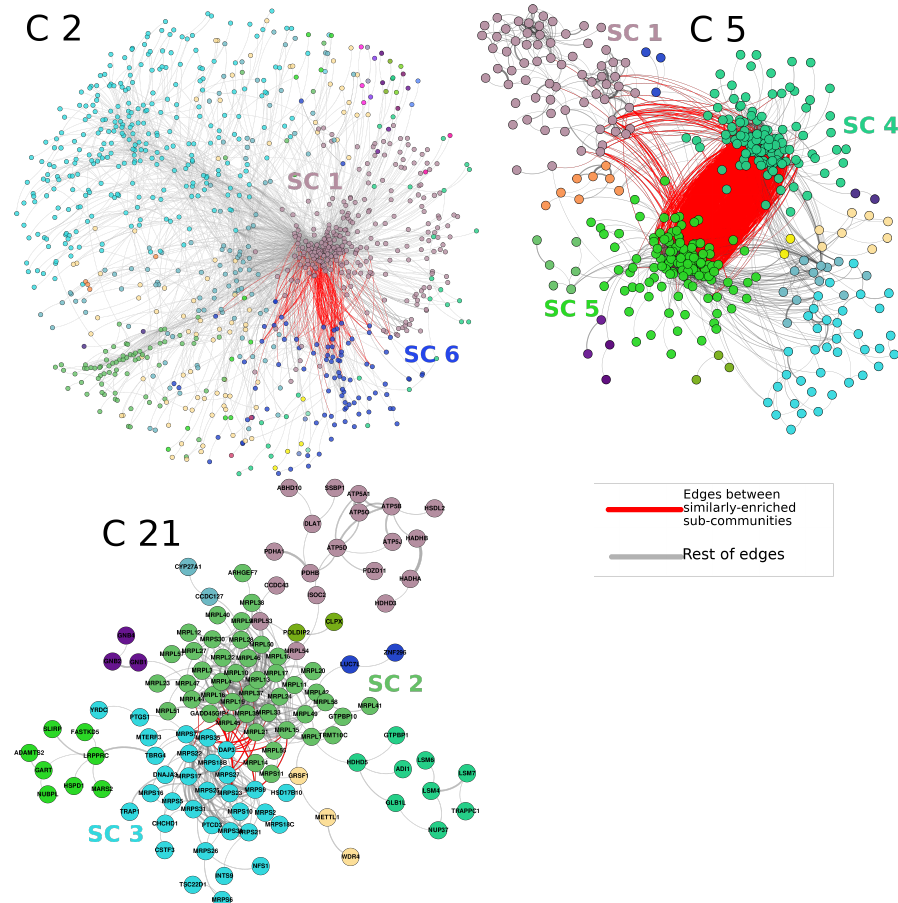
Figure 5. Network structure of three commonly enriched communities and their subcommunities. Each one of the networks shown here is statistically associated ( p -value < 1 × 10 − 5 ) with a common set of biological processes. The color of nodes groups genes of the same subcommunity. Red links represent interactions between genes of the subcommunities with a similar enrichment